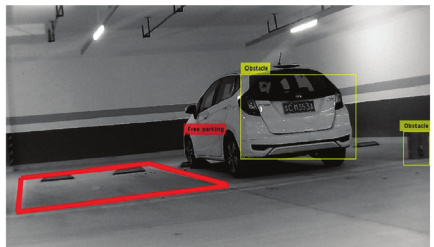
Figure 7: Parking detection based on